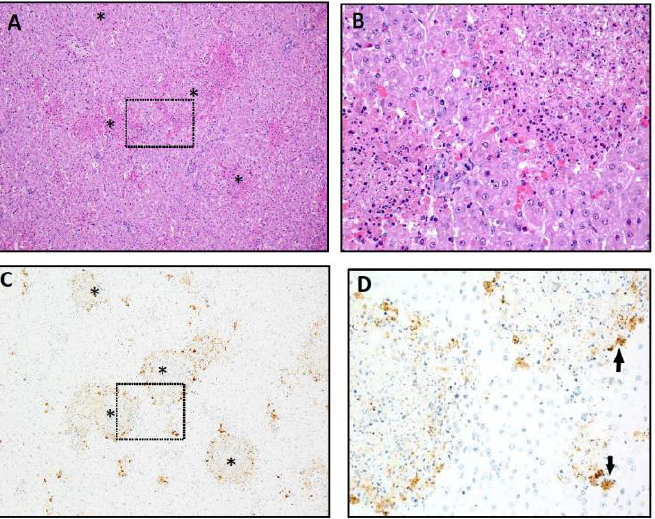
Figure 6. Hepatic lesions of a placebo vaccinated animal (#15. Group 5) that died of acute Rift Valley